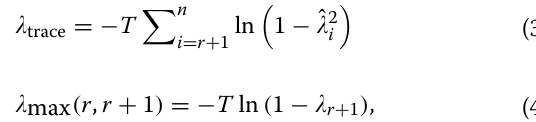
***Significant at 1% level of confidence ( p < 0.01), **Significant at 5% level of confidence ( p < 0.05), *Significant at 10% level of confidence ( p < 0.10) [ ] denotes p values a Sample size adjusted from 2003Q03 to 2018Q04